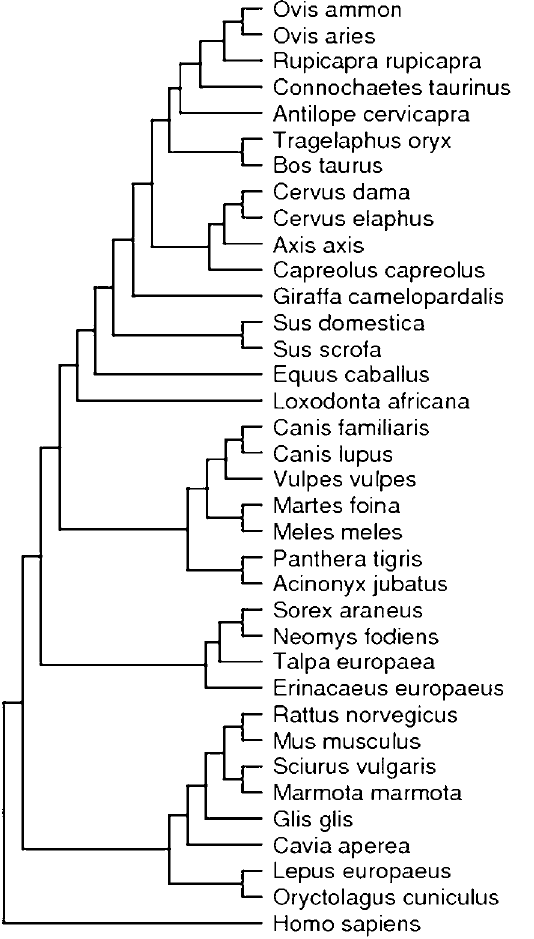
Figure 3. Phylogeny of the mammalian species investigated . Branch lengths are